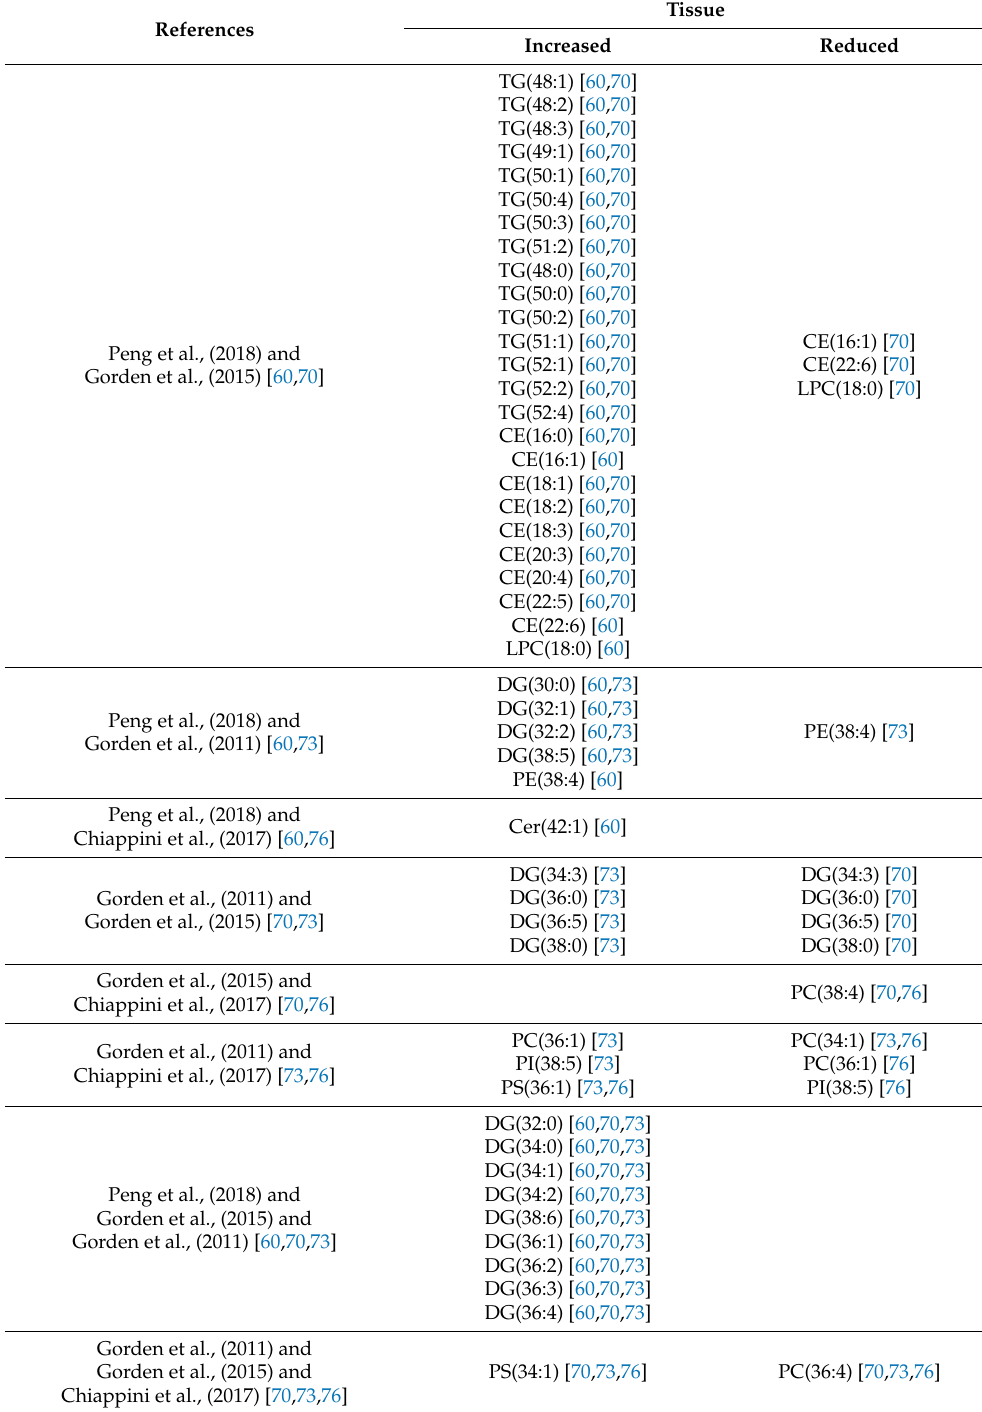
Table 2. Results from published studies on intrahepatic lipids in patients with